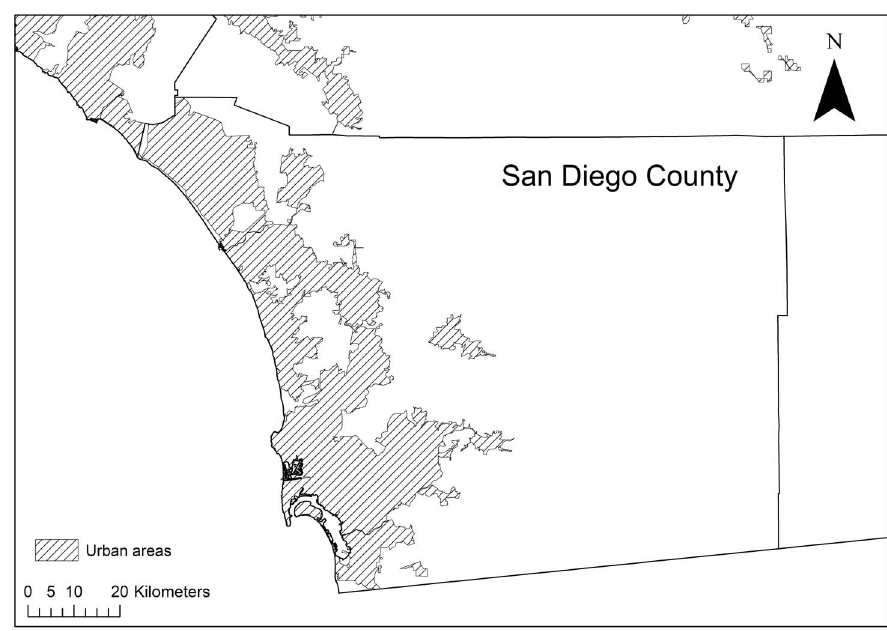
Figure 1. Location of the study area, San Diego County, USA.